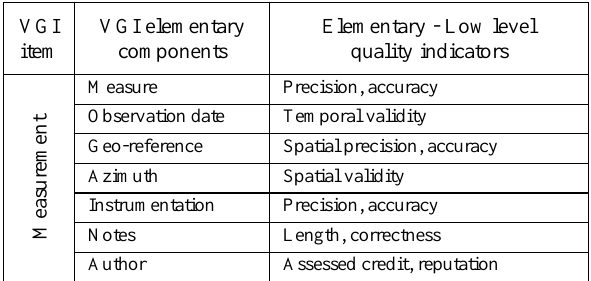
Table 2a: an example of VGI elementary components and correspondent elementary quality indicators for a picture item.